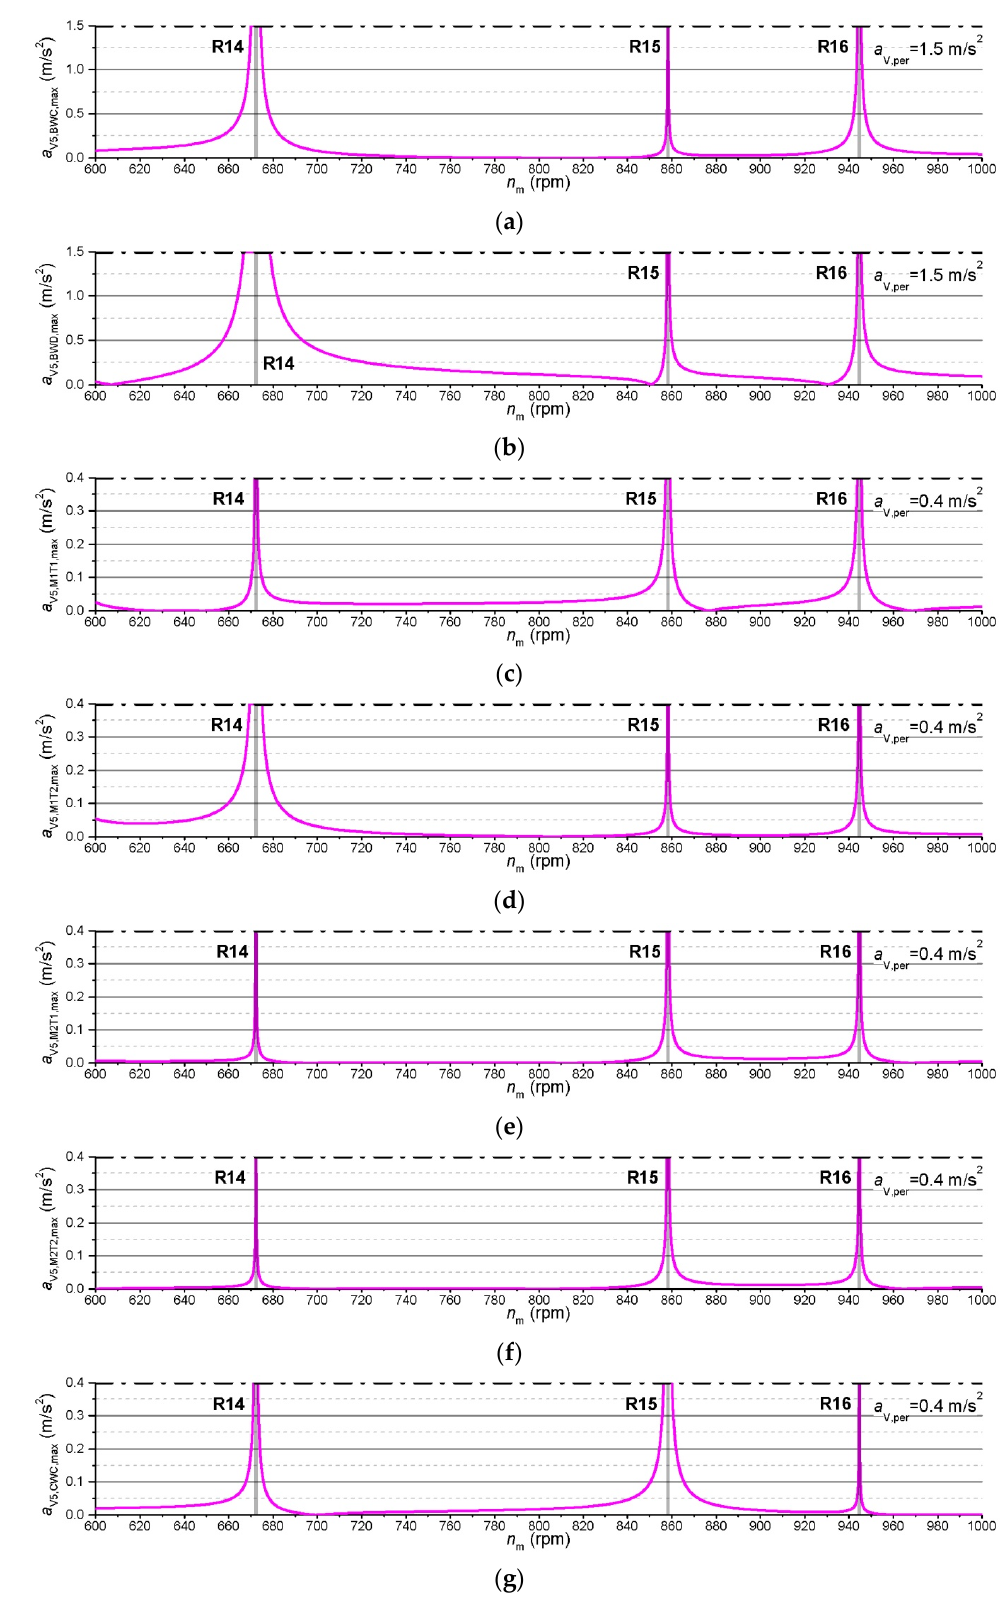
Figure 12. Response to the fifth harmonic of excitation—maximal vertical accelerations of the referent points of the slewing superstructure: ( a ) BWC; ( b ) BWD; ( c ) M1T1; ( d ) M1T2; ( e ) M2T1; ( f ) M2T2; ( g ) CWC.